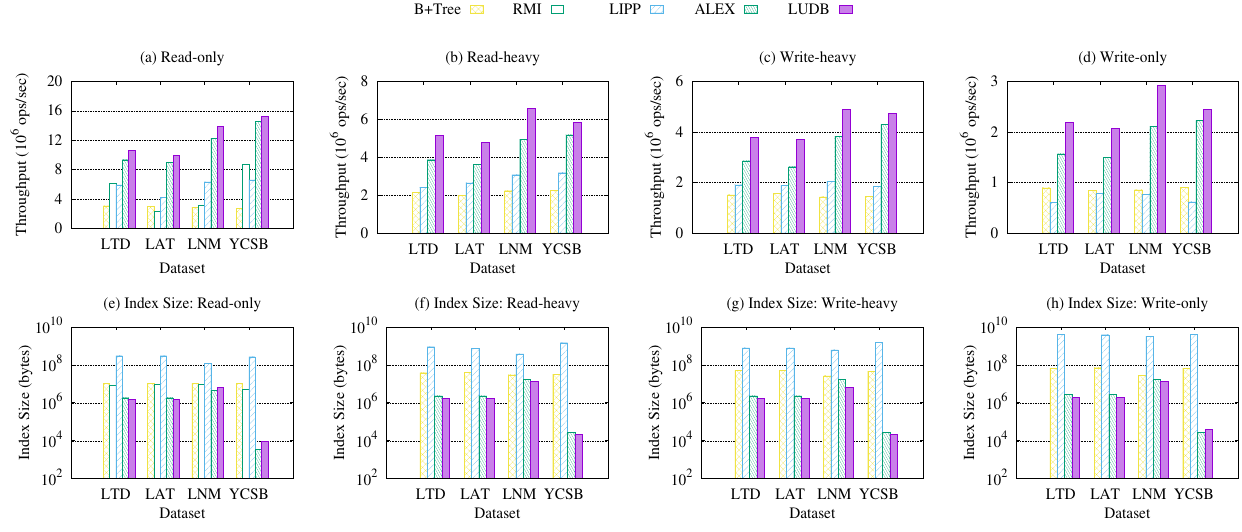
Figure 5. Throughput and index size: comparisons with other baselines. LUDB also achieves up to five orders of magnitude, 600×, 1200× index size smaller than LIPP, RMI, and B+Tree, as shown in Figure 5e. The index size of LUDB depends on how well the index structure models the dataset distribution. For the YCSB dataset, it is highly linear, so LUDB does not need massive models to model the distribution. Then, the index size of the dataset is smaller than other datasets. However, for the LAT dataset, which is highly nonlinear, LUDB requires many models to model its distribution, so it has a larger index size compared with other datasets. This phenomenon suggests that, if LUDB only needs a few models, it will have higher throughput and smaller index size. Furthermore, LUDB also sets a bound of node sizes to achieve faster merge operation and smaller index size. Then, LUDB can reduce bulk load time and obtain a better index